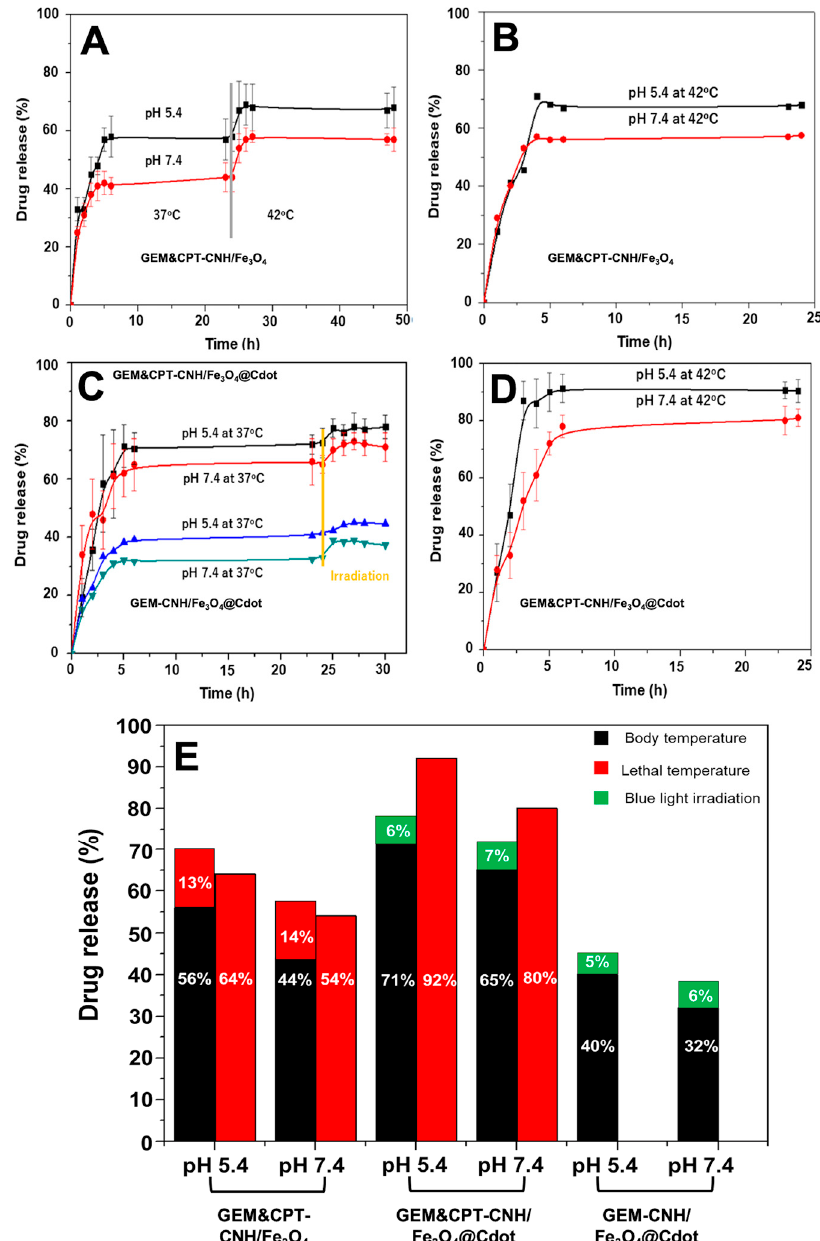
Figure 8. GEM-release at PH 5.4 and 7.4 from ( A ) GEM&CPT@CNH/Fe 3 O 4 at 37 ◦ C and heating at 42 ◦ C after 24 h and ( B ) GEM&CPT@CNH/Fe 3 O 4 at 42 ◦ C, ( C ) GEM@CNH/Fe 3 O 4 @Cdot and GEM&CPT@CNH/Fe 3 O 4 @Cdot at 37 ◦ C with blue LED irradiation after 24 h, and ( D ) GEM&CPT@CNH/Fe 3 O 4 @Cdot at 42 ◦ C and ( E ) GEM release from drug-loaded CNH/Fe 3 O 4 and CNH/Fe 3 O 4 @Cdot under different